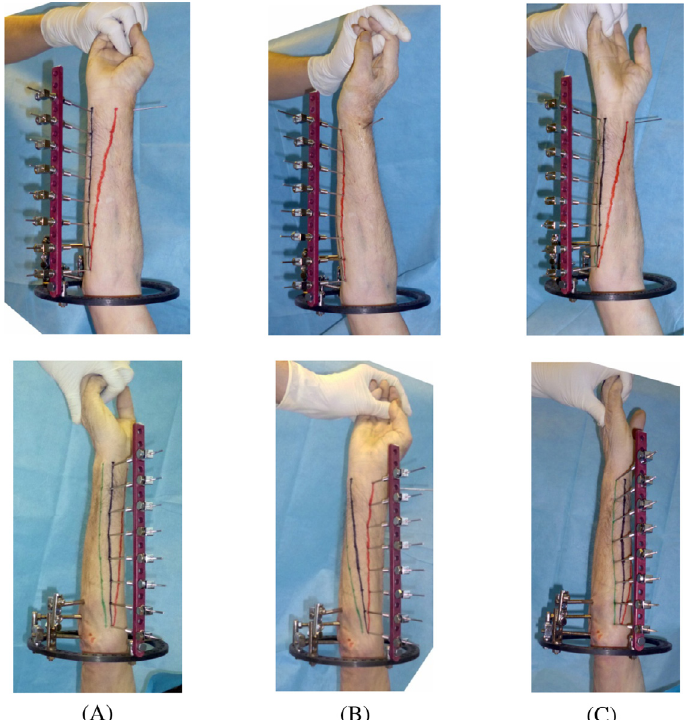
Figure 3. (A) Initial position relative to the ulna in the projection of position 5 (black line). (B) Pronation of forearm up to 70 (cid:2) (red line). (C) Supination of forearm up to 70 (cid:2) (green line).